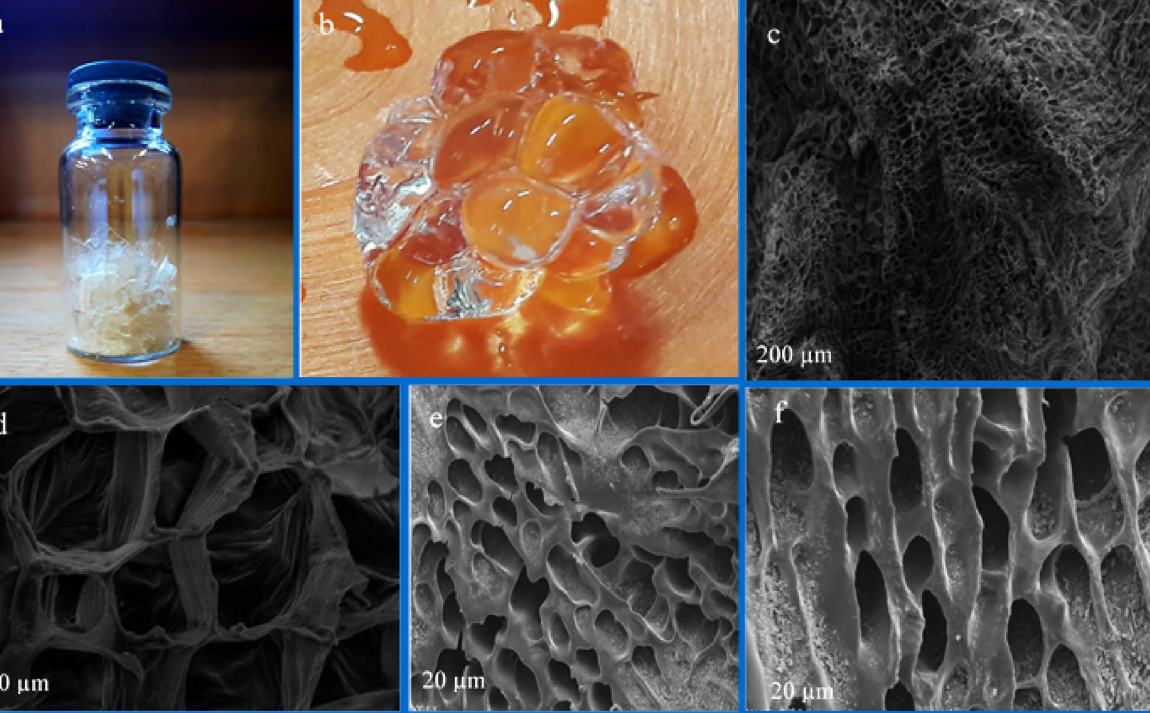
Figure 3. Digital photos of p(AA-co-AM-co-MA) in dry ( a ) and swollen modes ( b ), respectively. SEM micrographs of p(AA-co-AM-co-MA) superabsorbent ( c , d ), and SEM micrographs of p(AA-co-AM) superabsorbent ( e , f